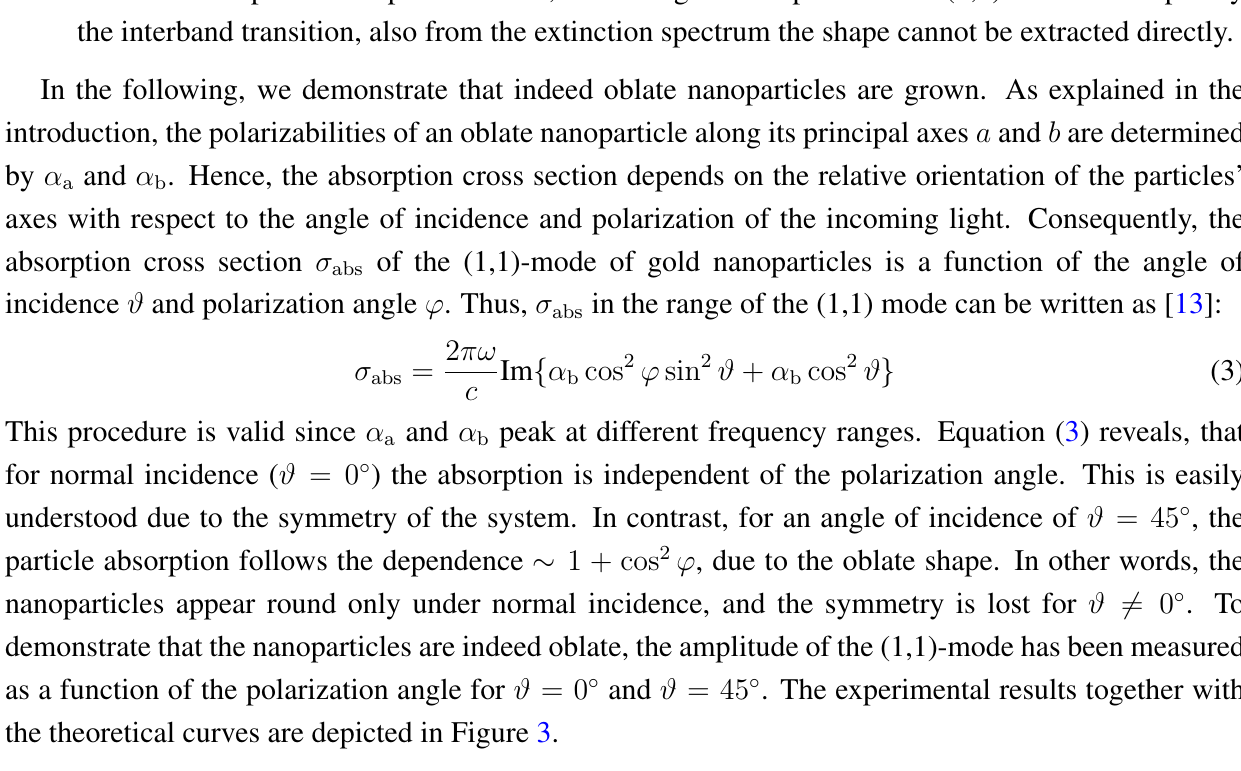
Figure 3. Amplitude of the (1,1)-mode as a function of the polarization angle φ for gold ⟩ = (5 . 5 ± 0 . 3) nm. ( a ) Angle of incidence ϑ = 0 o and ( b ) angle of particles with a ⟨ R eq incidence ϑ = 45 o